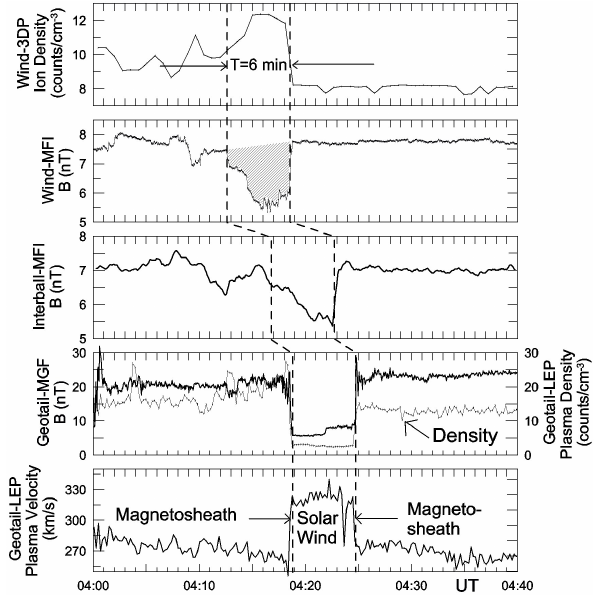
is confined between the two vertical dashed lines. The pulse ap- parently modulates the traces of magnetic field and plasma moment measurements obtained via the Interball, Wind and Geotail satel- lites. The magnetic field strength, the density and velocity are mea- sured in nanoteslas, cm − 3 , and km/s,